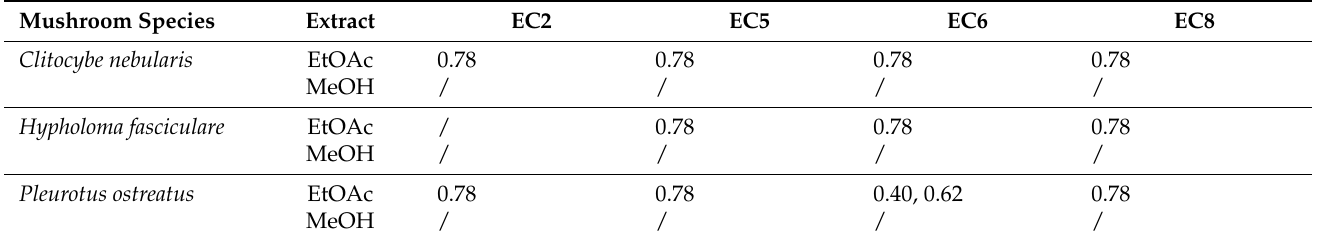
Table 4. Rf values of inhibition bands induced by mushrooms extracts on bioautograms against the four MDR E. coli strains EC2, EC5, EC6, and